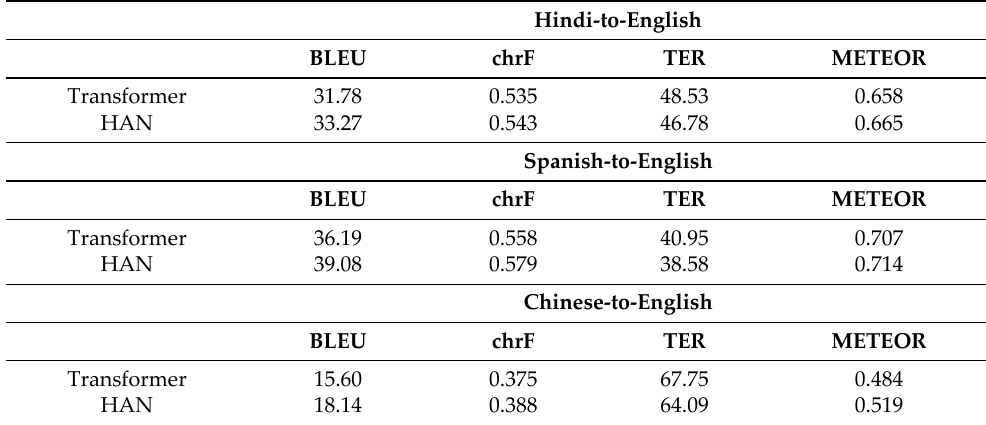
Table 4. Baseline scores of NMT systems